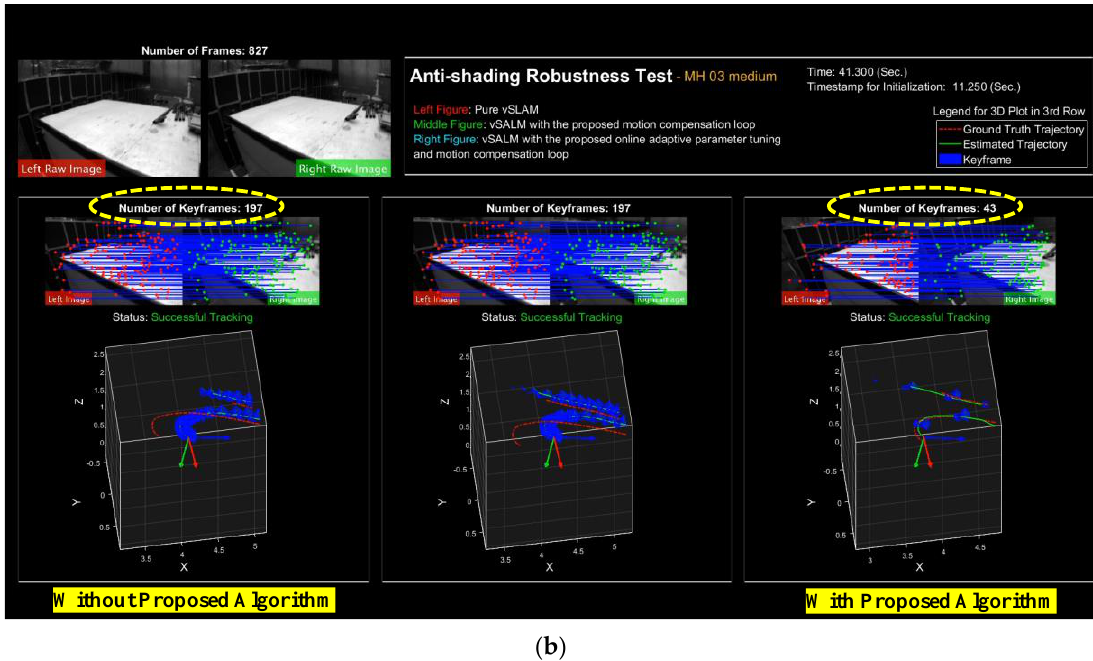
Figure 26. The results of the anti-shading robustness test with MH_03_medium series: ( a ) Anti- shading robustness examination (Supplementary File Vedio S1); ( b ) Key frame examination ( X - Y - Z axis Unit: